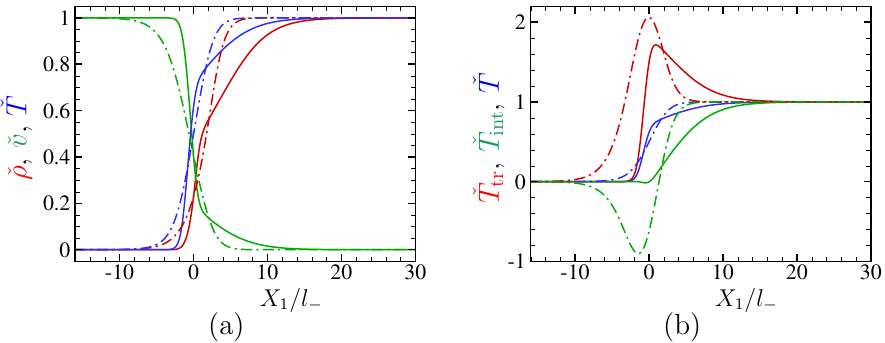
Figure 5. Profiles of ˇ ρ , ˇ v , ˇ T , ˇ T tr , and ˇ T int in the case of the pseudo-CO 2 gas at M − = 3 for µ b / µ = 10. ( a ) ˇ ρ , ˇ v , and ˇ T ; ( b ) ˇ T tr , ˇ T int , and ˇ T . See the caption of Figure